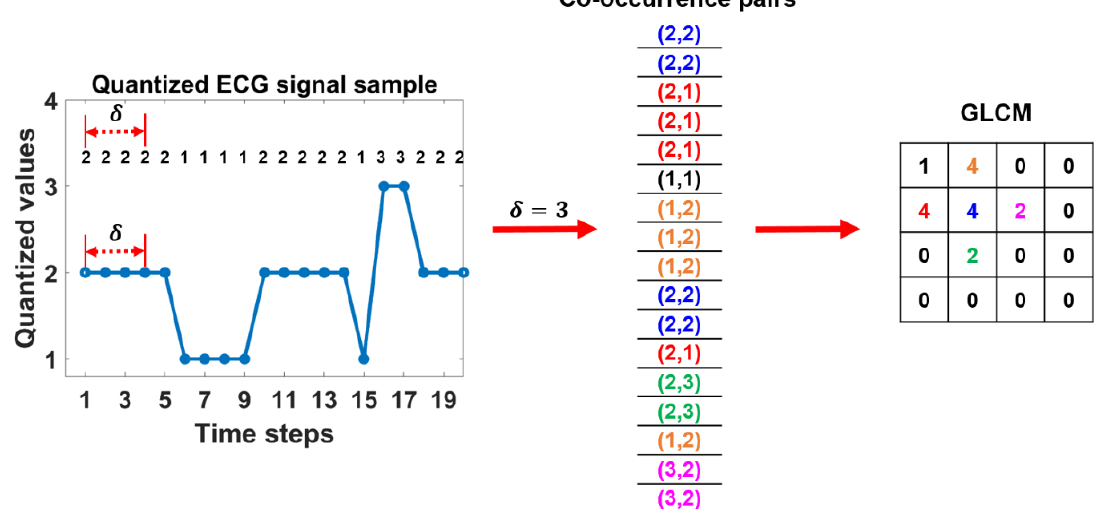
Figure 2. The process of generating the GLCM for a quantized ECG signal. Table 2. GLCM features. 𝑔(𝑖, 𝑗) is the normalized GLCM. 𝜇 and 𝜎 are the mean and standard deviation of 𝑔(𝑖, 𝑗) , re- 𝑝 spectively. 𝑔 𝑥+𝑦 (𝑘) is obtained from ∑ ∑ 𝑔(𝑖, 𝑗) 𝑝 and 𝑘 = 𝑖 + 𝑗 . 𝑗 𝑖